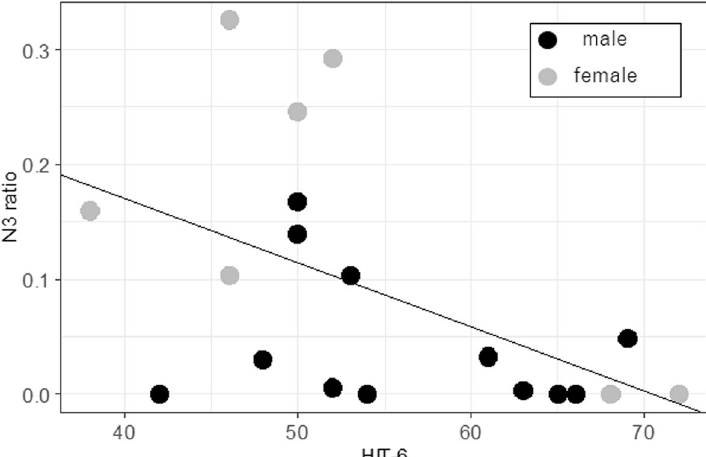
Fig. 1 Relationship between HIT-6 score and ratio of sleep stage N3. Black and grey circles correspond to data for male and female, respectively. In the simple regression analysis, the slope and intercept were -0.00056